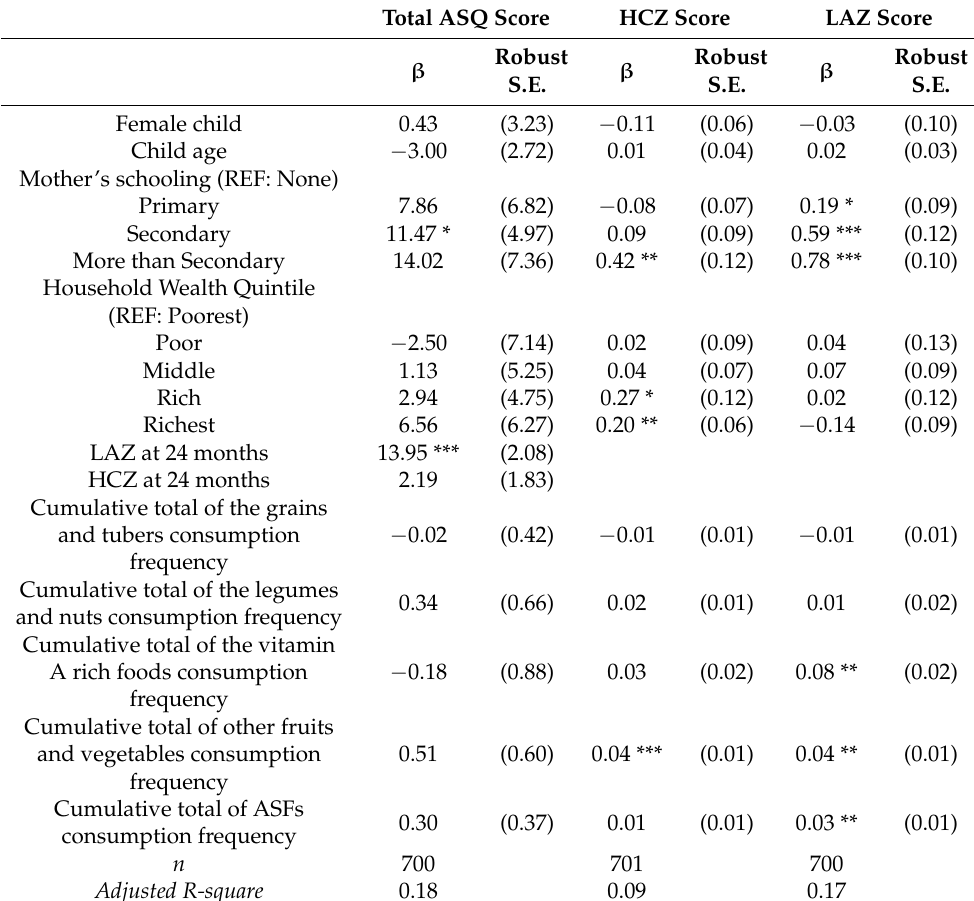
Table A5. Association between ASQ score, HCZ and LAZ, and the cumulative total of the food group consumption